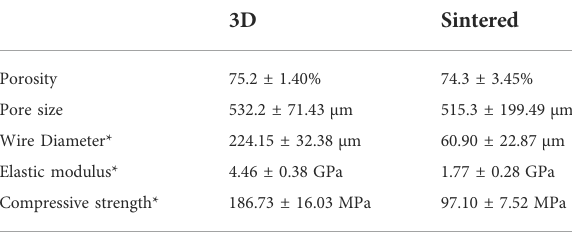
TABLE 1 The numerical differences of the physical parameters of the porous structures in the two groups.